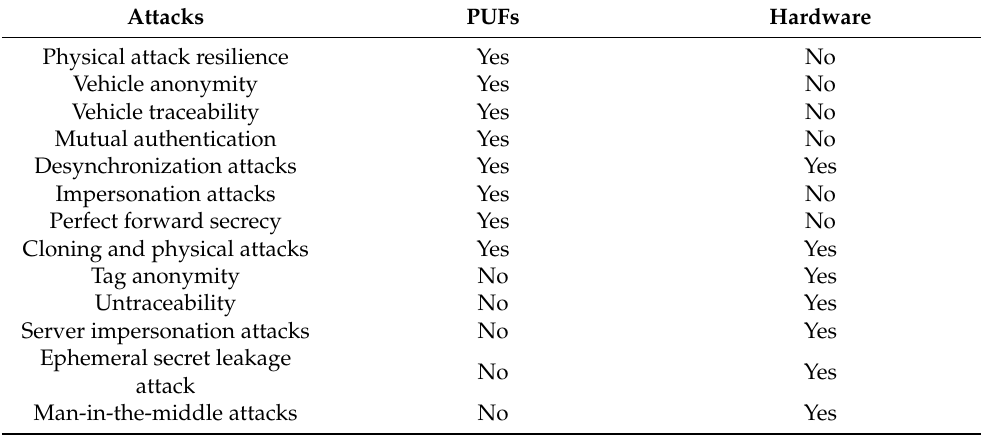
Table 20. Comparison based on attacks mitigated by hardware-based (PUFs vs hardware)